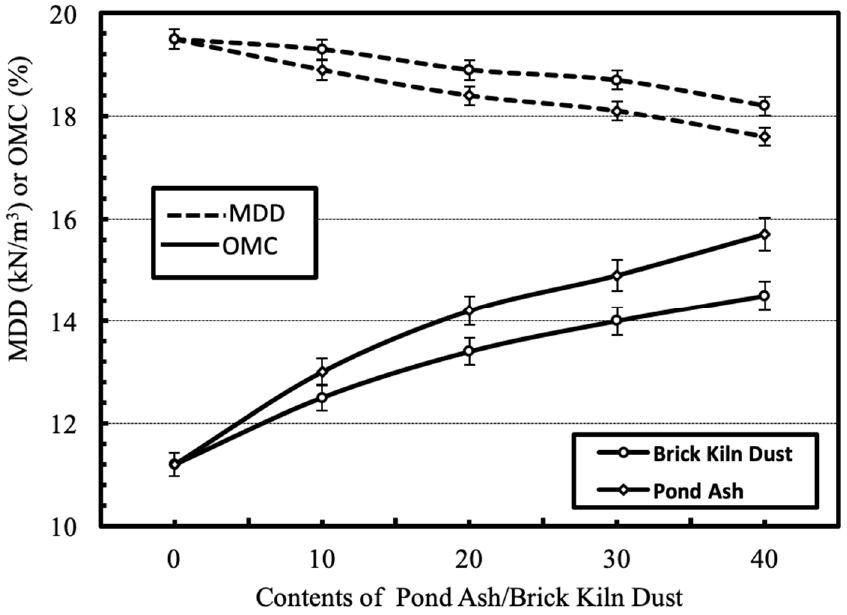
Figure 8. Variation in compaction characteristics with varying contents of pond ash or brick kiln dust.